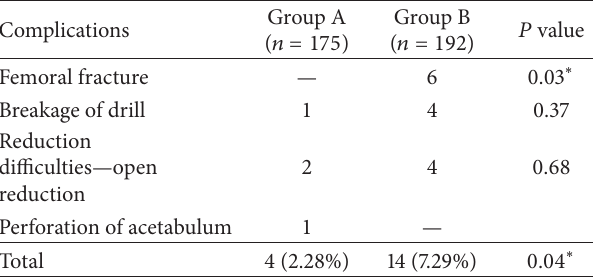
Table 2: Intraoperative